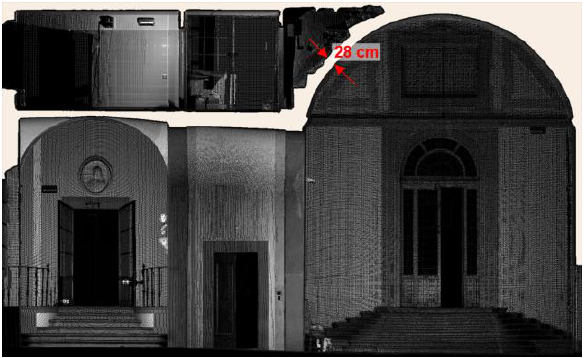
Figure 10. The orthoimage of the point model show that the thickness of the reins of the big vault is approx. 28